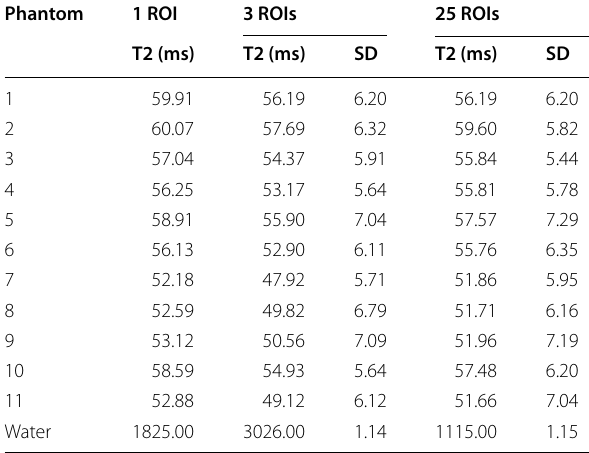
Table 8 T2 values of all agar gel phantoms at TP1 Phantom